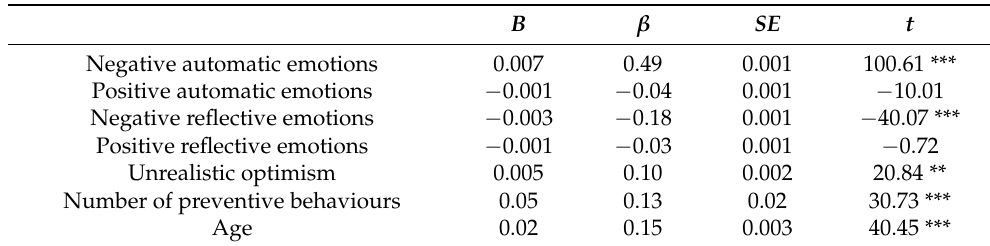
Table 1. Regression (for whole group) with general anxiety as a dependent variable. The